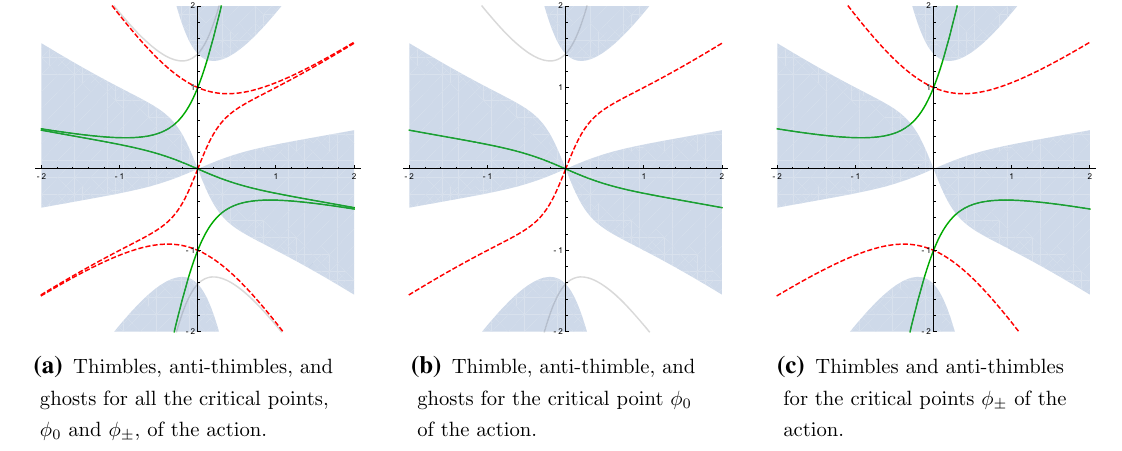
for the critical points φ ± of the action. correspond to solution y 1 , orange solid curves to the solution y 2 , green solid curves to the solution y 3 and the red solid curve to the solution y 4 . The shaded regions denote the regions where Re ( S ) ≥ 0